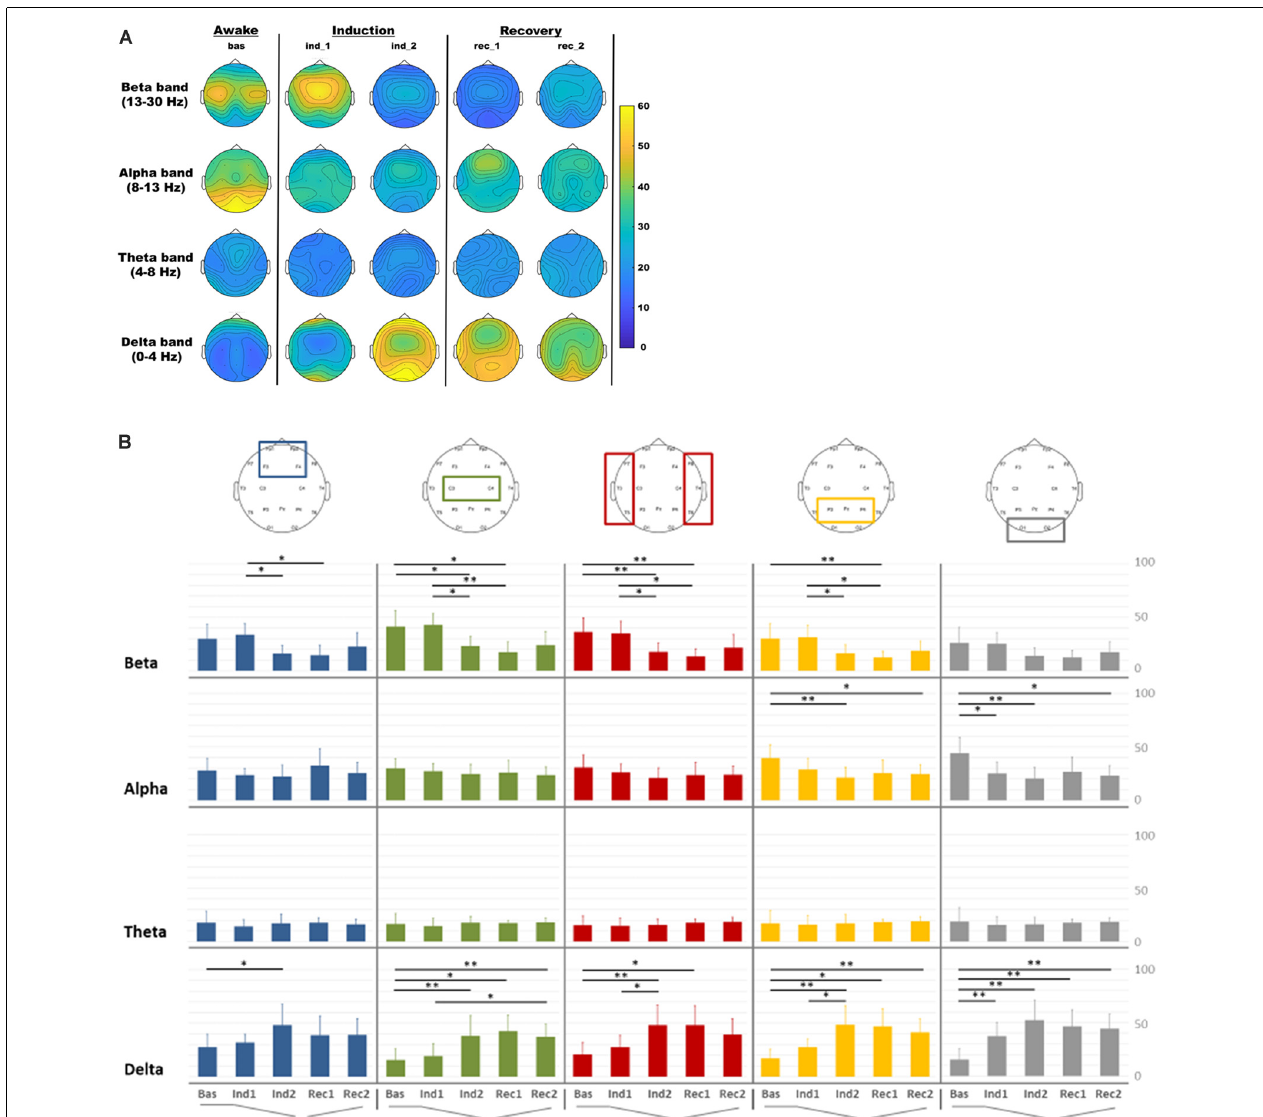
FIGURE 2 | Electroencephalography (EEG) relative power distribution for delta, theta, alpha, and beta bands in each condition. (A) EEG relative power maps. (B) EEG relative spectral power comparisons among regions of interest (ROIs) for each band analyzed in each condition: baseline (Bas), beginning phase of administration of propofol (Ind1), loss of consciousness (Ind2), propofol infusion stopped (Rec1) and pre-recovery of consciousness (Rec2) period for frontal (blue), central (green), temporal (red), parietal (orange) and occipital (gray) ROIs. ∗ p < 0.05; ∗∗ p <